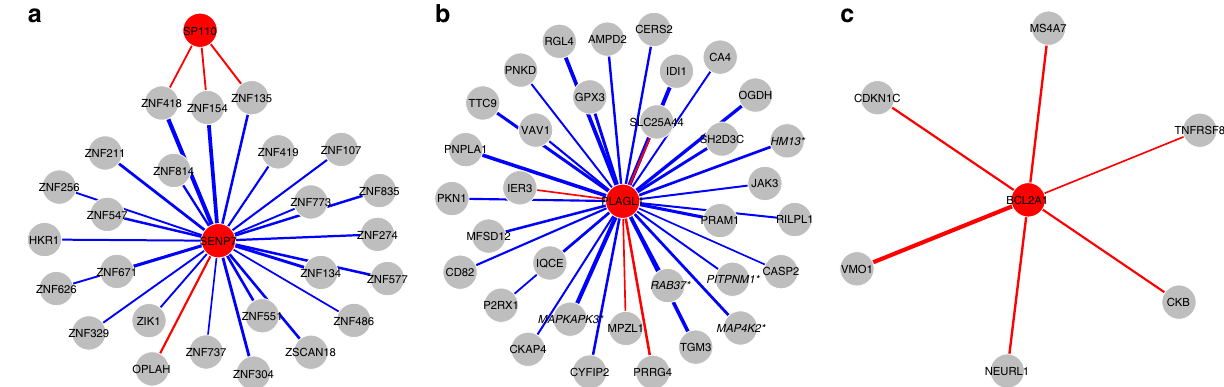
Fig. 4 Identi fi ed target genes for different index genes. Panels show target genes for SENP7 and SP110 ( a ), PLAGL1 ( b ), and BCL2A1 ( c ). Starred and italic gene names indicate previously reported target genes 23, 24, 38, 80 (Supplementary Data 7). Blue and red lines indicate positive and negative associations, respectively; line thickness indicates strength of the association